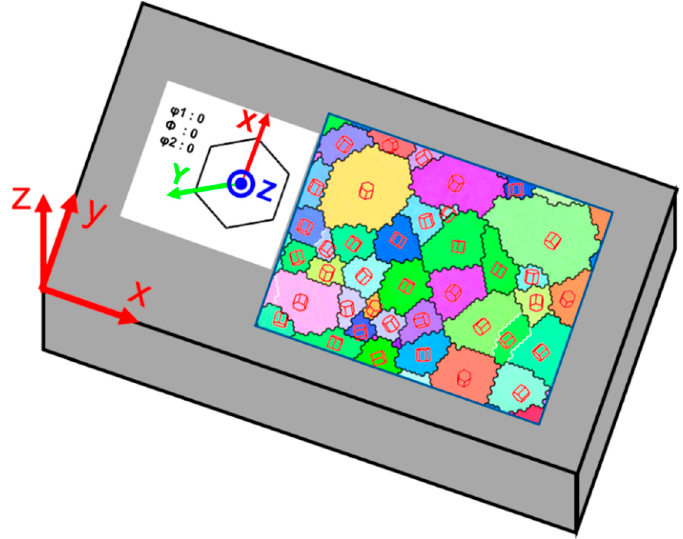
Figure 2. Schematic diagram showing the relationship between the crystal with Euler angles (0°, 0°, 0°) and its rotation axis, as well as the cartesian coordinate system. An example of an EBSD inverse pole figure (IPF) map in the cartesian coordinate system is also shown.